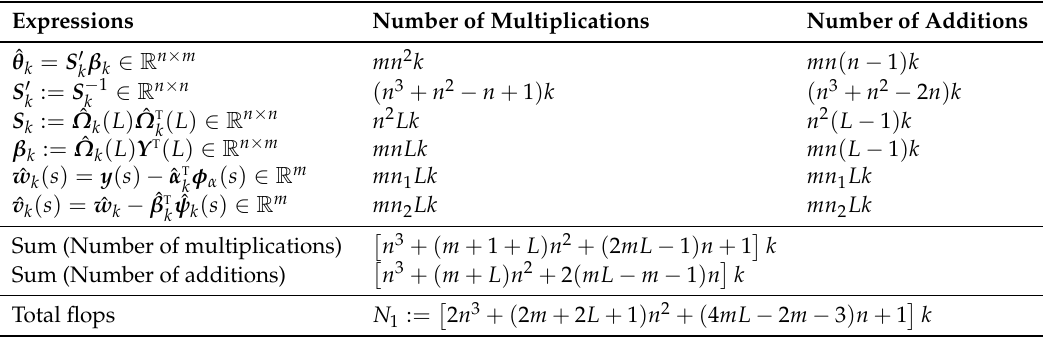
Table 1. The computational efficiency of the least-squares-based iterative identification